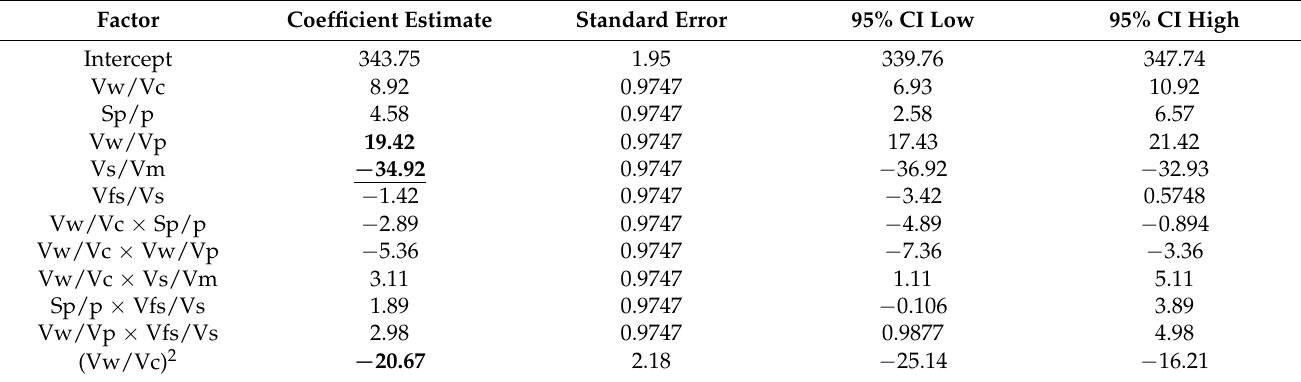
Table 6. D-flow model coefficients in terms of coded